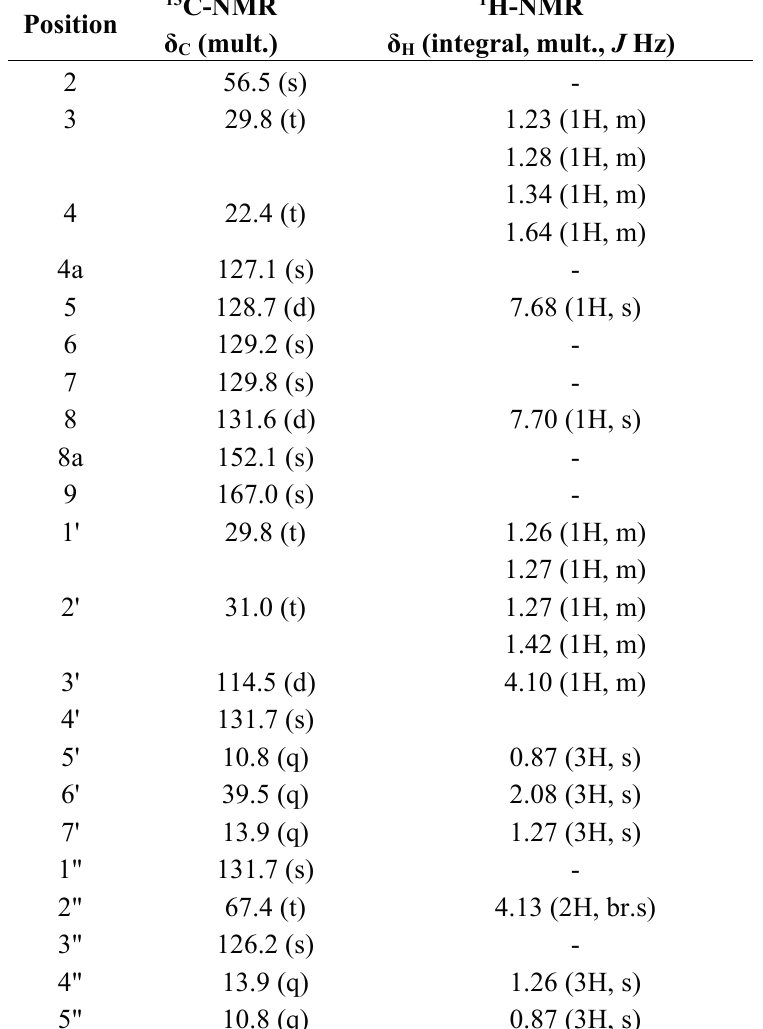
1 H-NMR δ (integral, mult., J Hz) H